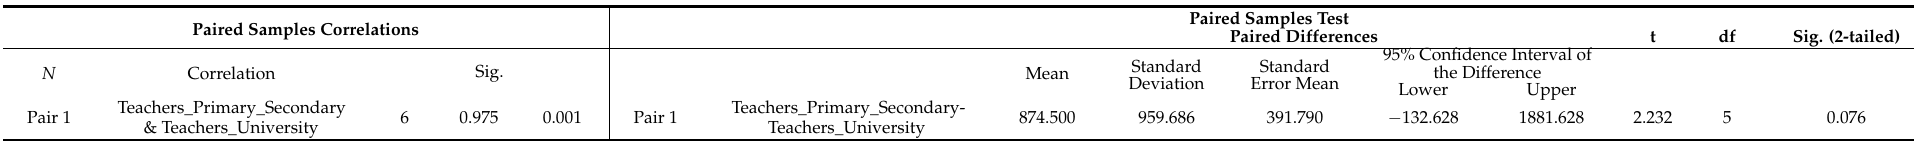
Table 25. Paired samples t-test applied for the perspective of primary and secondary education level teachers and perspective of academic teachers on online testing methods (Quizzes and Forms).